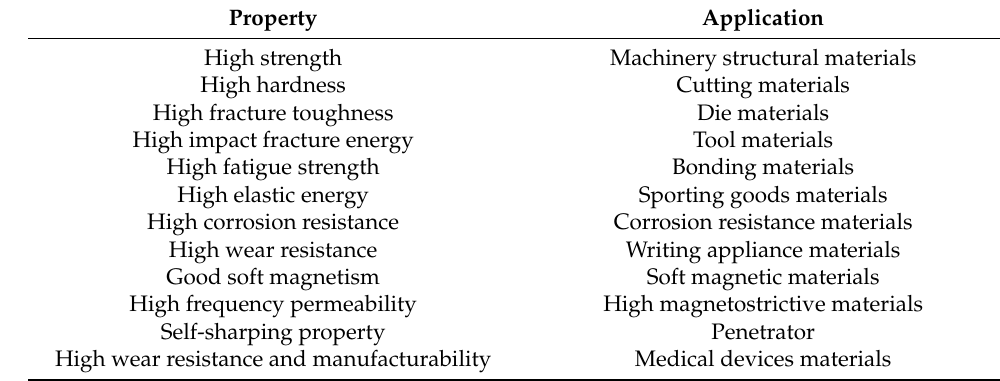
Table 2. Properties and potential applications of bulk metallic glasses (BMGs) [36].